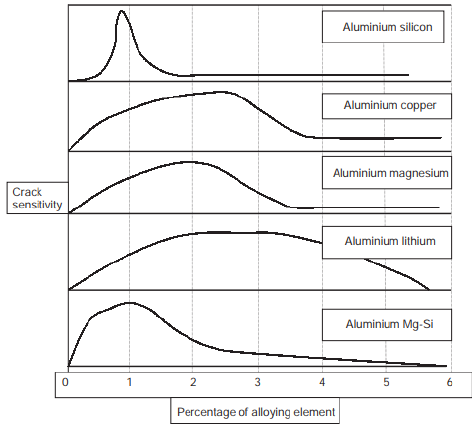
Figure 5. Graphs of crack sensitivity for different alloying elements in an Al matrix [74].